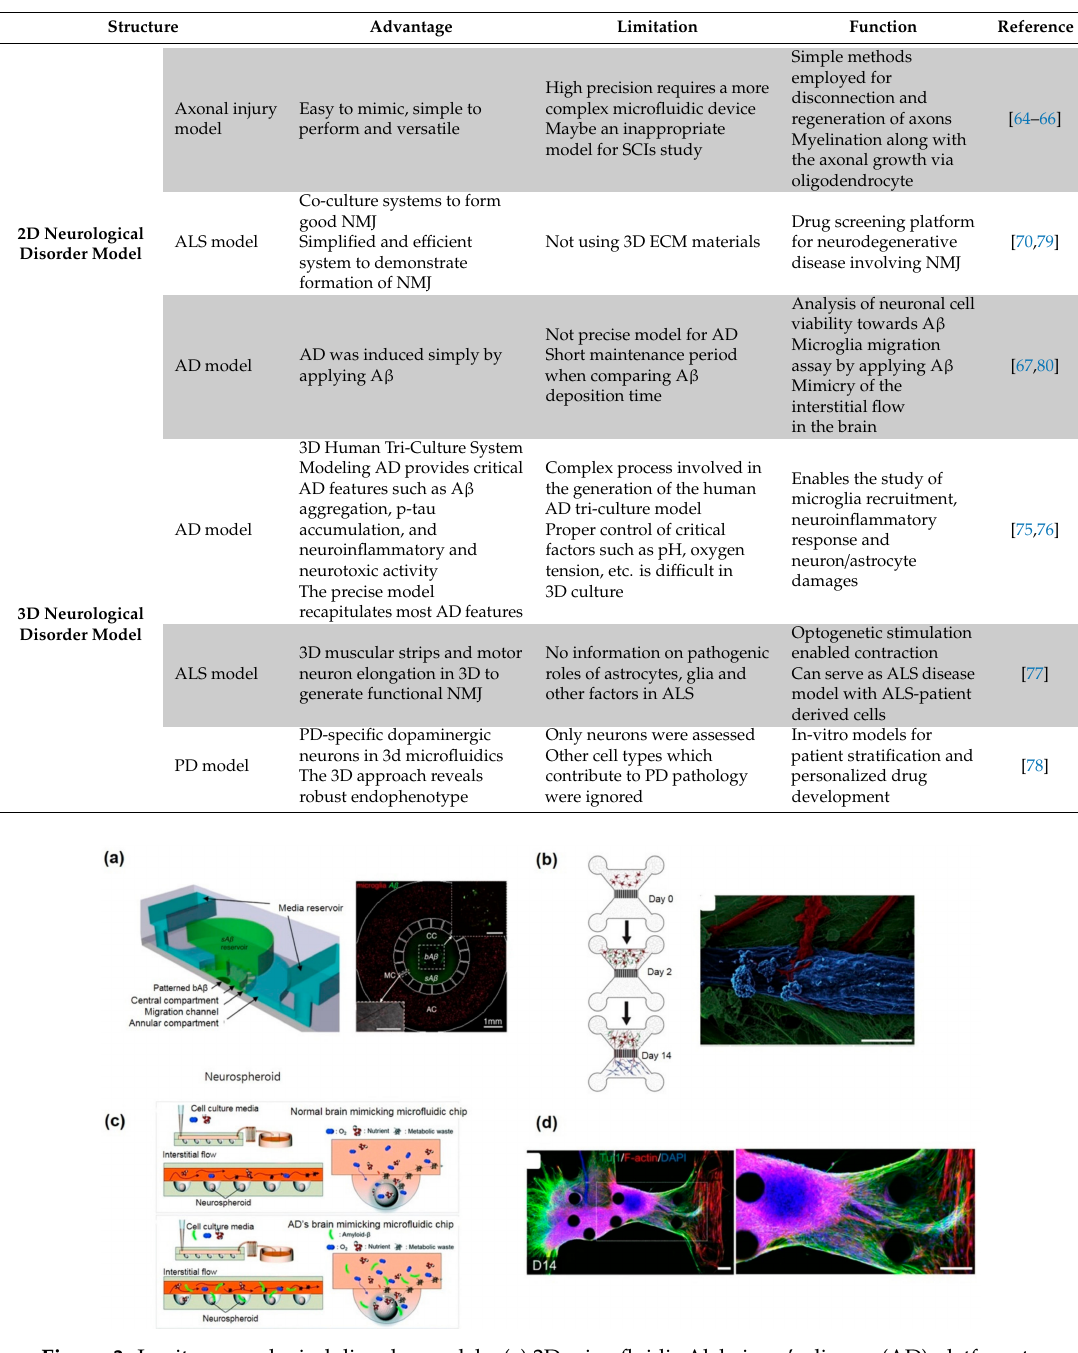
Figure 3. In vitro neurological disorder models. ( a ) 2D microfluidic Alzheimer’s disease (AD) platform to study microglial responses to various types of A β . Reproduced with permission from [67], copyright 2013 under creative common license (attribution—noncommercial). ( b ) 2D compartmentalized